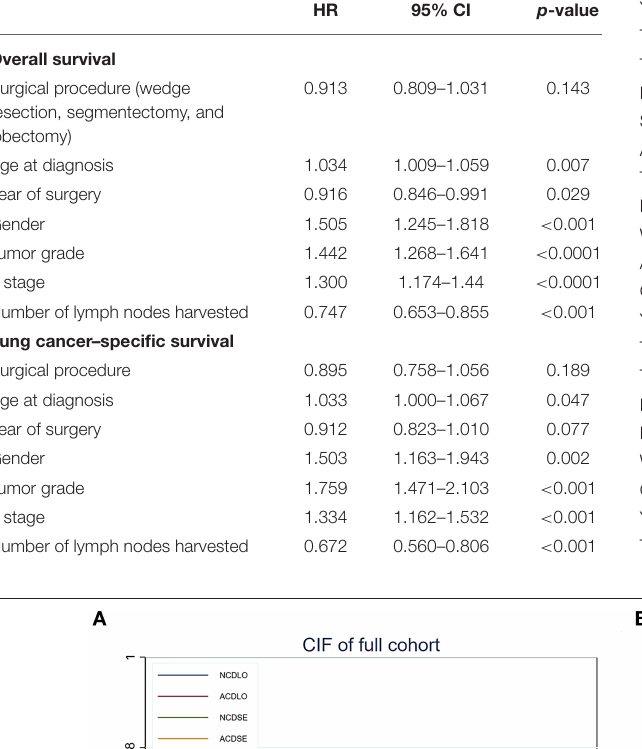
TABLE 2 | Matched Cox multivariate regression.